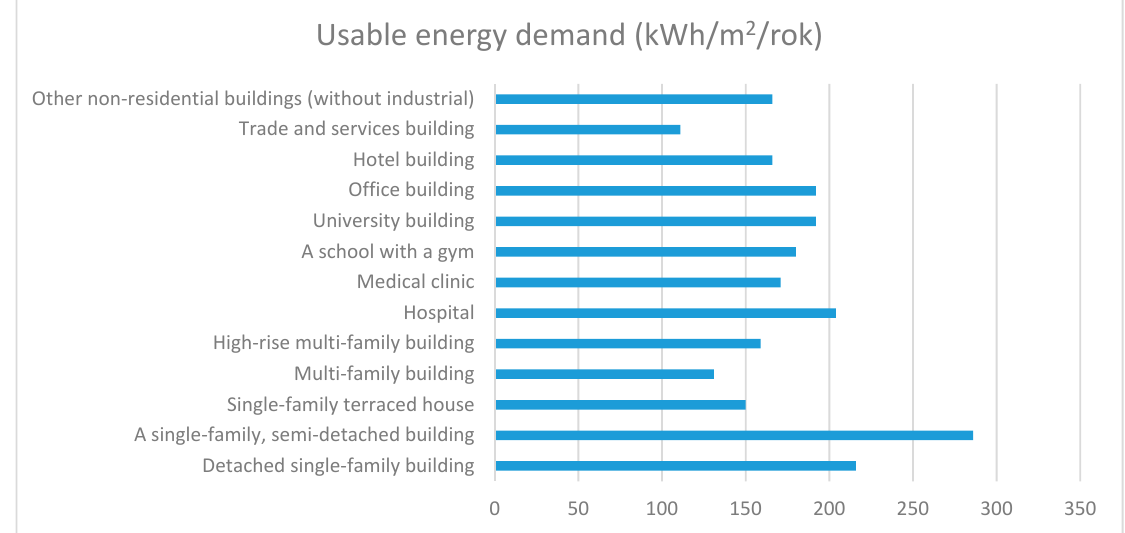
Figure 3. Usable energy demand in Poland according to type of building (source: [31]). High-capacity heat pumps are systematically gaining importance in the heating in- dustry market. They are used in every climatic zone and fulfill a wide range of functions. With an appropriate system design, you can use both heating and cooling opportunities, transforming one-way energy consumption into cyclical energy management. Heat plants